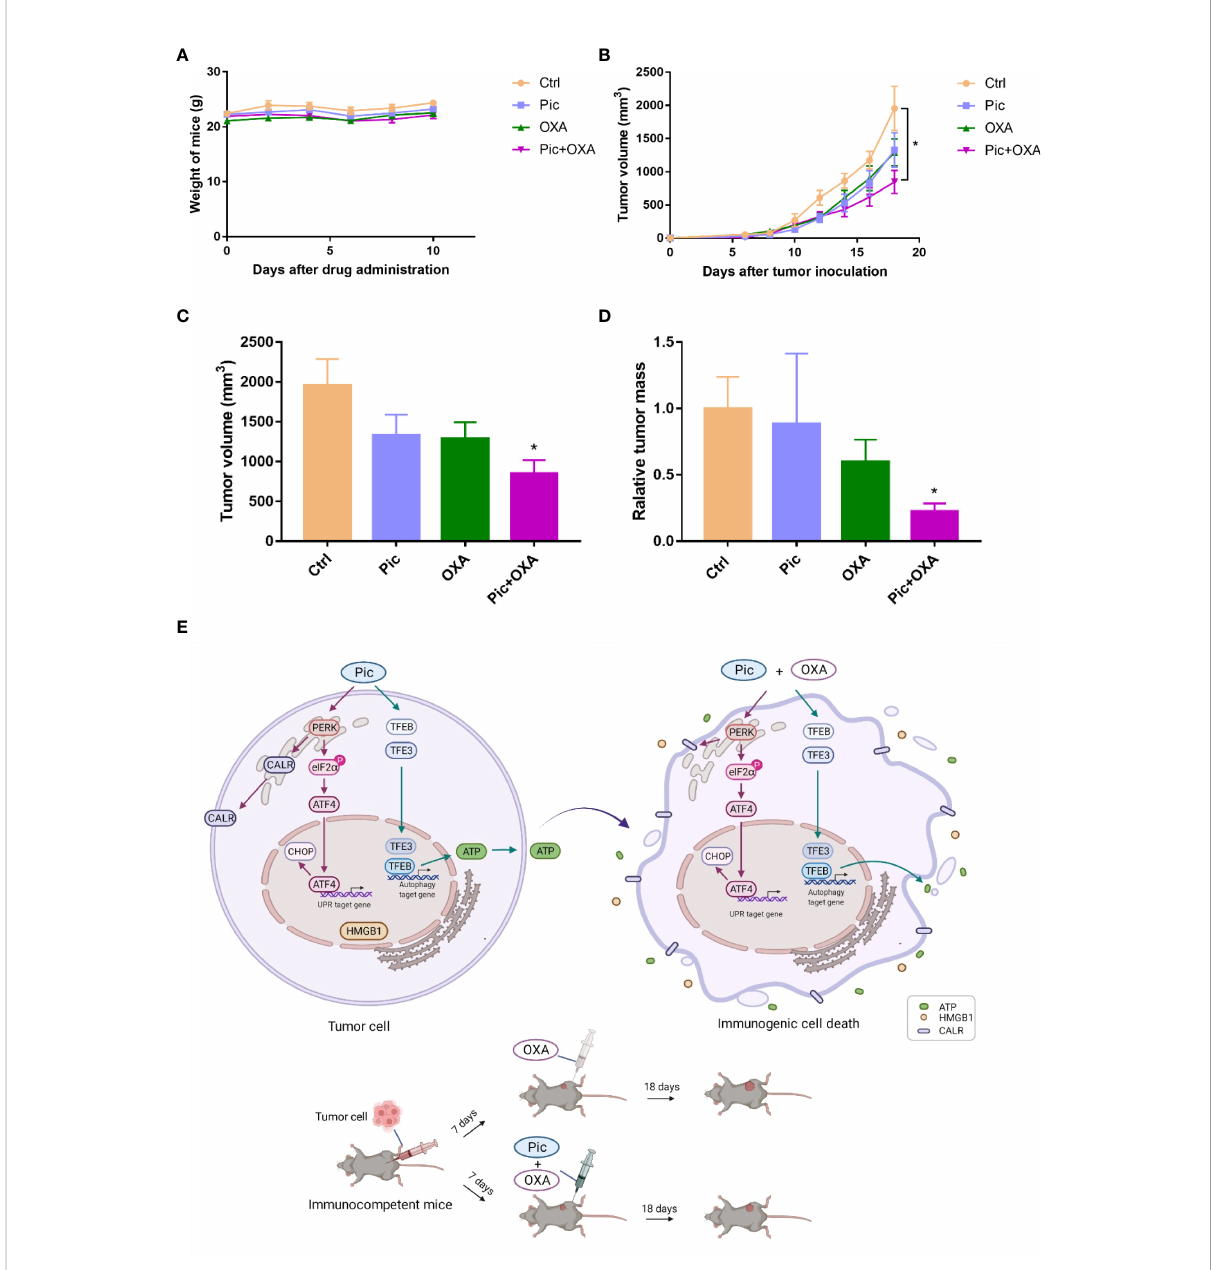
FIGURE 7 Piceatannol enhances the ef fi cacy of anticancer chemotherapy of OXA in immunocompetent C57BL/6J mice. (A) Piceatannol (Pic), OXA low , or their combination (Pic+OXA low ) does not obviously affect the body weight of C57BL/6J mice-bearing MCA205 tumor. (B) Growth curves (mean ± SEM) results show that Pic enhances the role of OXA low in inhibiting tumor growth. (C, D) Pic enhances the role of OXA low in reducing tumor volume (C) and weight (D) . (E) Schematic model showing the synergistic effect of Pic in enhancing low concentration of OXA-induced anti- tumor effect via amplifying ICD hallmarks. Mechanistically, Pic activated TFEB/TFE3 to induce autophagy, which was critical for its role in inducing ATP release and synergizing with OXA to boost ATP release. In addition, Pic induced ER stress, and activated PERK-involved UPR response. Speci fi cally, Pic increased the phosphorylation of eIF2 a , and increased ATF4 and CHOP level. This activated PERK/p-eIF2 a /ATF4 axis triggered low level of cell surface CALR exposure and further promoted OXA-induced high level of cell surface CALR exposure. Additionally, Pic also synergized with OXA to enhance HMGB1 release. Consequently, Pic enhanced OXA-induced anticancer activity in immunocompetent mice bearing tumor cells possibly via its synergistic effect with OXA in amplifying ICD hallmarks. Unpaired T-test is used for statistical analysis. * p -value <